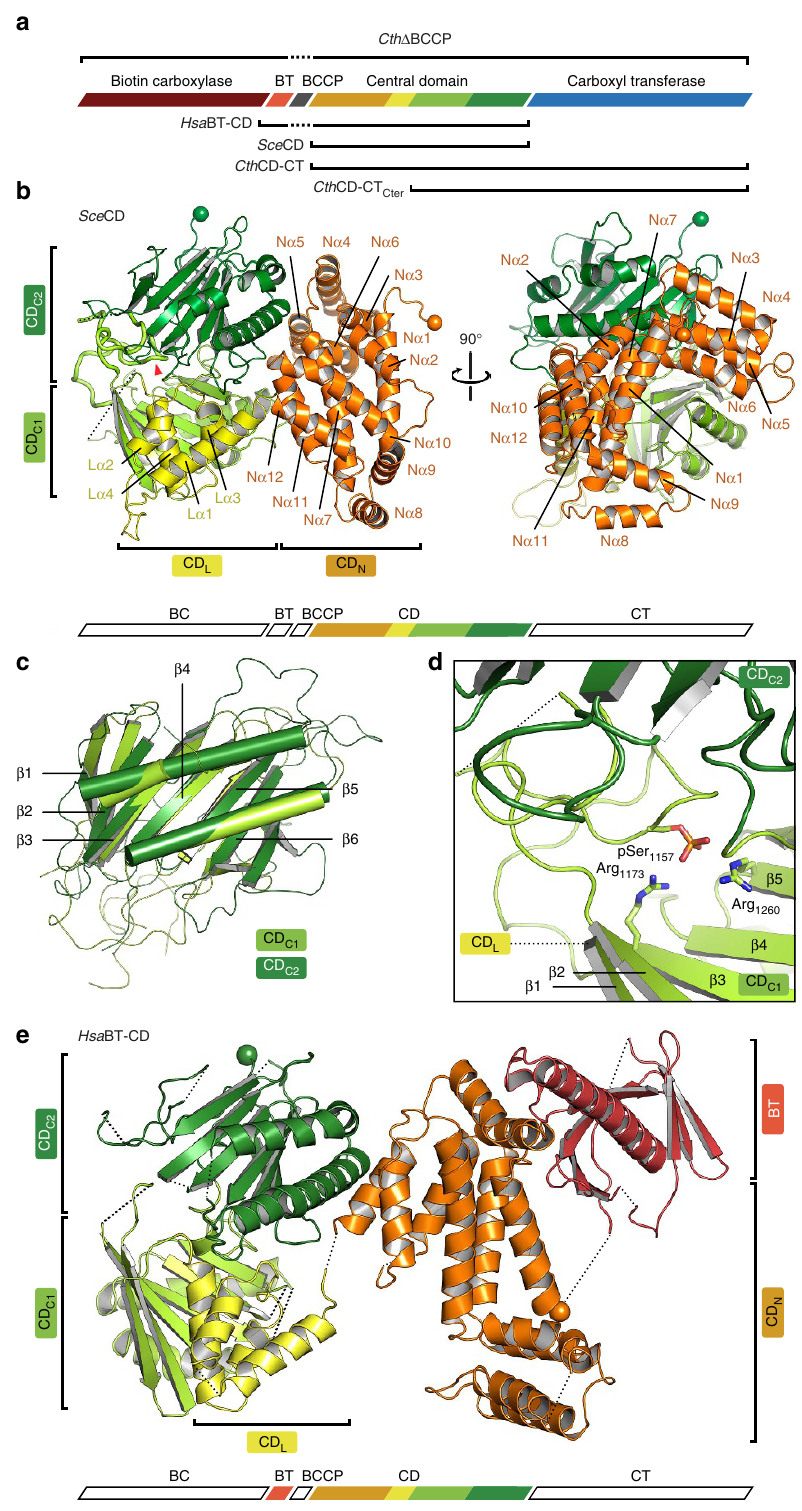
Figure 1 | The phosphorylated central domain of yeast ACC. ( a ) Schematic overview of the domain organization of eukaryotic ACCs. Crystallized constructs are indicated. ( b ) Cartoon representation of the Sce CD crystal structure. CD N is linked by a four-helix bundle (CD L ) to two a – b -fold domains (CD C1 and CD C2 ). The regulatory loop is shown as bold cartoon, and the phosphorylated Ser1157 is marked by a red triangle. The N- and C termini are indicated by spheres. ( c ) Superposition of CD C1 and CD C2 reveals highly conserved folds. ( d ) The regulatory loop with the phosphorylated Ser1157 is bound into a crevice between CD C1 and CD C2 , the conserved residues Arg1173 and Arg1260 coordinate the phosphoryl-group. ( e ) Structural overview of Hsa BT-CD. The attachment points to the N-terminal BCCP domain and the C-terminal CT domain are indicated with spheres. All colourings are according to scheme a